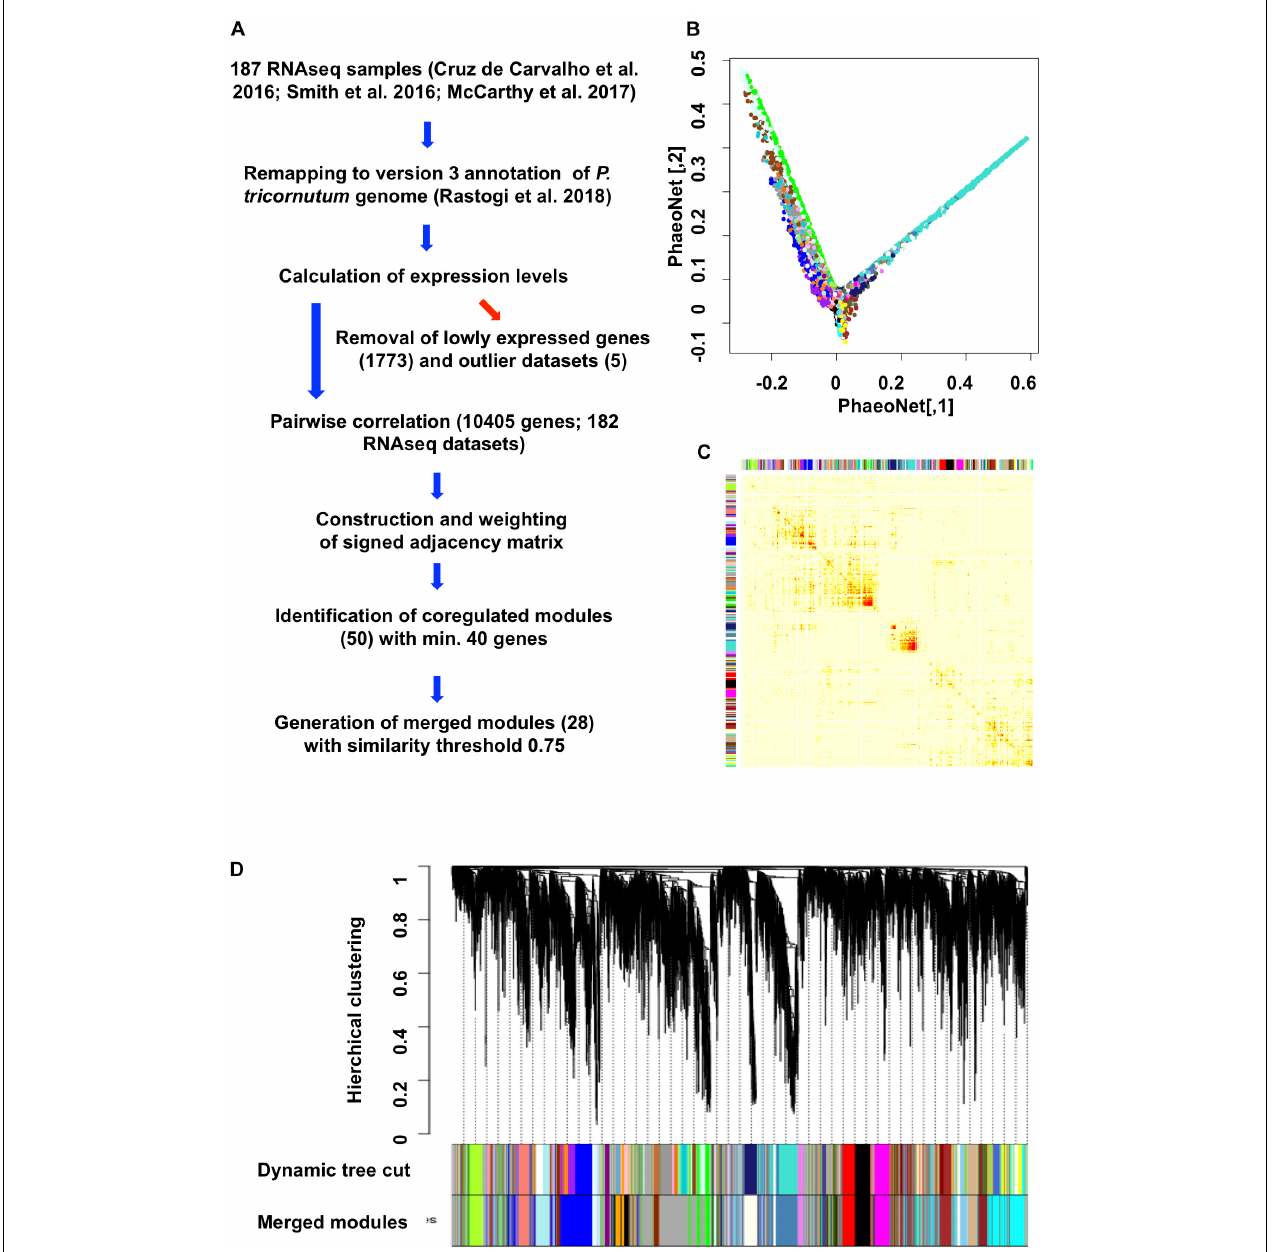
FIGURE 1 | Construction and topology of PhaeoNet. (A) Workflow diagram of the steps performed to construct PhaeoNet. (B) A Multi-Dimensional Scaling (MDS) plot of PhaeoNet. The dots correspond to genes and the colors correspond to the WGCNA modules. The tips of the plot correspond to hub genes of PhaeoNet. (C) Heatmap plot showing the TOM supplemented by the WGCNA module colors prior to merging. (D) Gene dendrogram of all incorporated PhaeoNet genes, obtained by average linkage hierarchical clustering. The first color row underneath the dendrogram shows the WGCNA module assignment obtained by the Dynamic Tree Cut method. The bottom color row shows the merged modules based on a correlation threshold of 0.75.